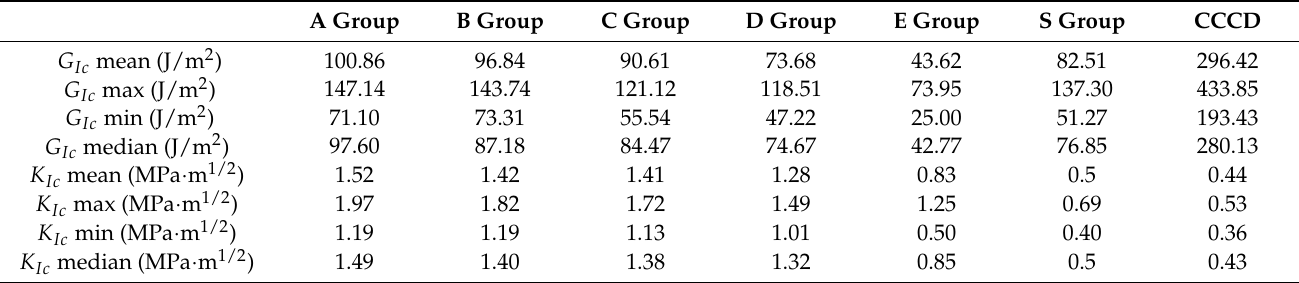
Table 4. Statistical analysis of G Ic and K Ic .